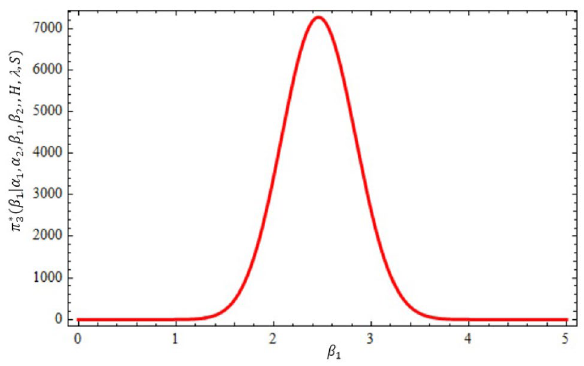
Figure 5. The conditional posterior density of MCMC results of the β 1 parameter.